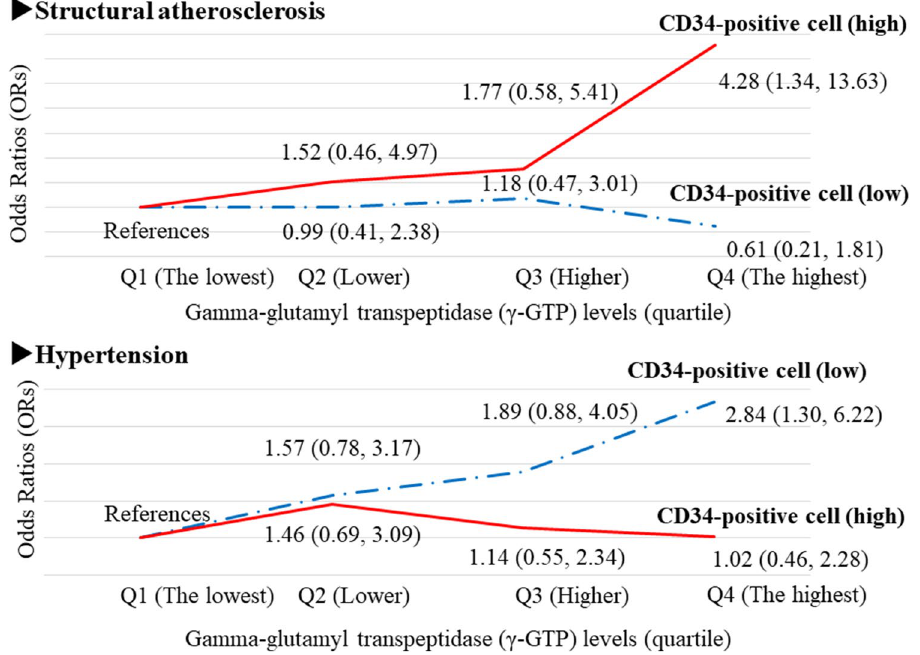
Figure 5. Association among gamma-glutamyl transpeptidase (γ-GTP), hypertension, structural atherosclerosis 27 . Q1: The lowest quartile level. Q2: Lower quartile level, Q3: Higher quartile level. Q4: The highest quartile level.